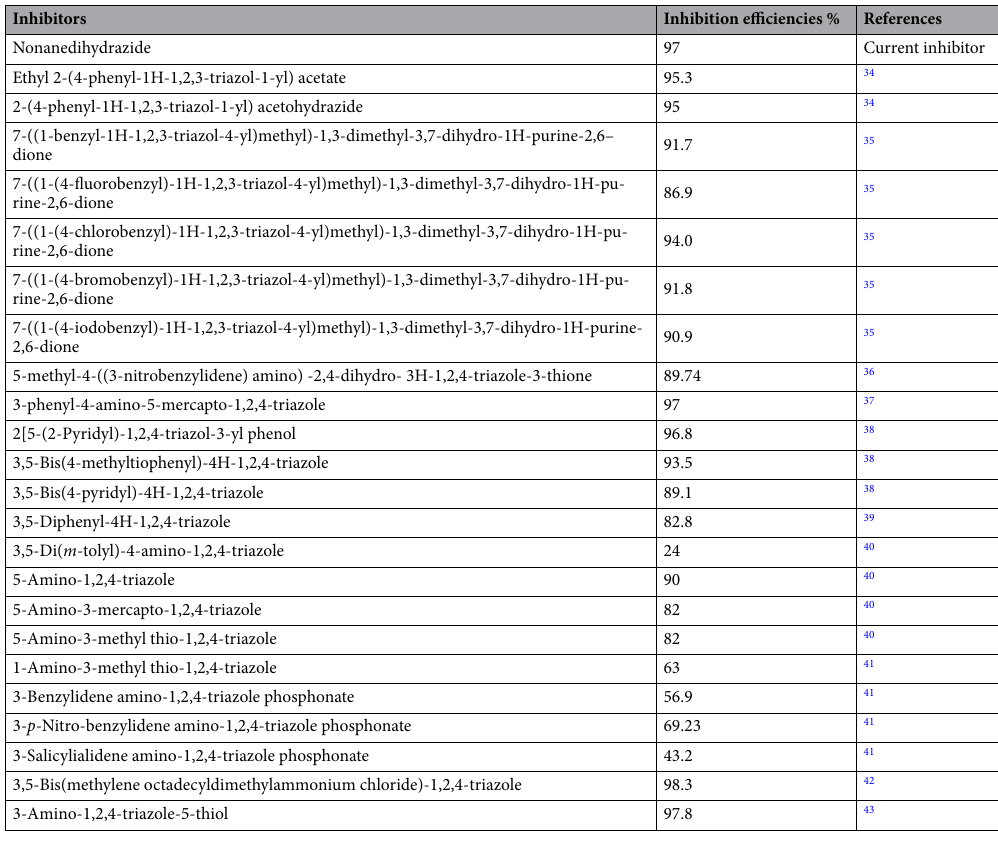
Table 1. Comparison of the inhibitory efficiency of nonanedihydrazide to other triazoles.